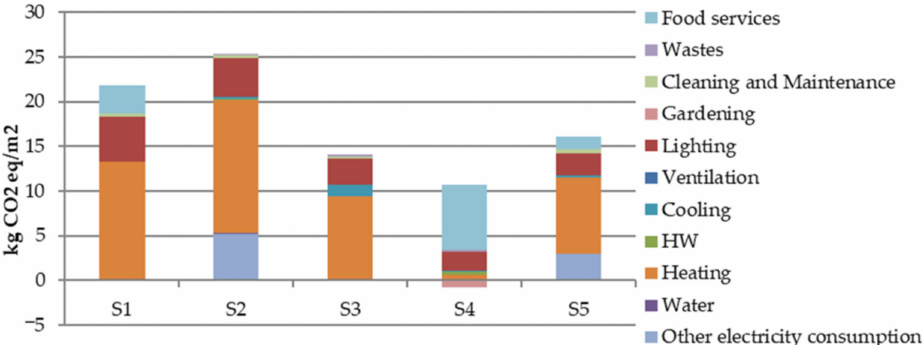
Figure 4. CC impact per m 2 and year, per school, and activity of the building